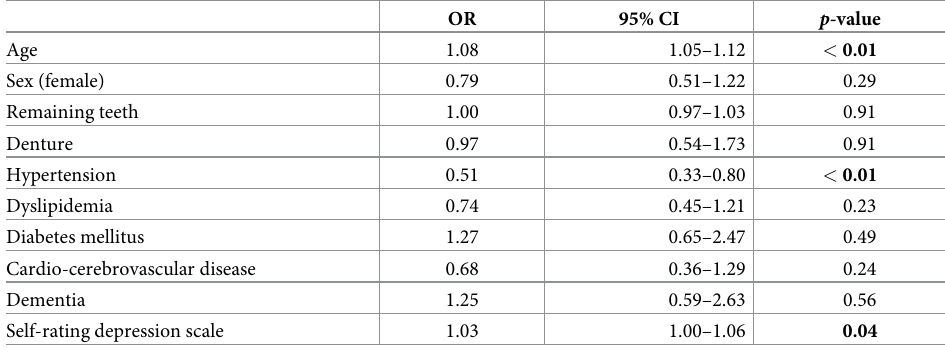
Self-rating depression scale 1.03 1.00–1.06